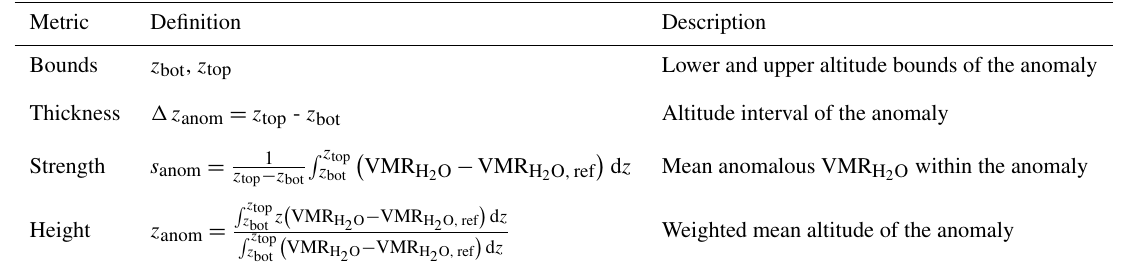
Table 1. Characterization metrics of moisture anomalies, their definitions and short descriptions. VMR H vapour